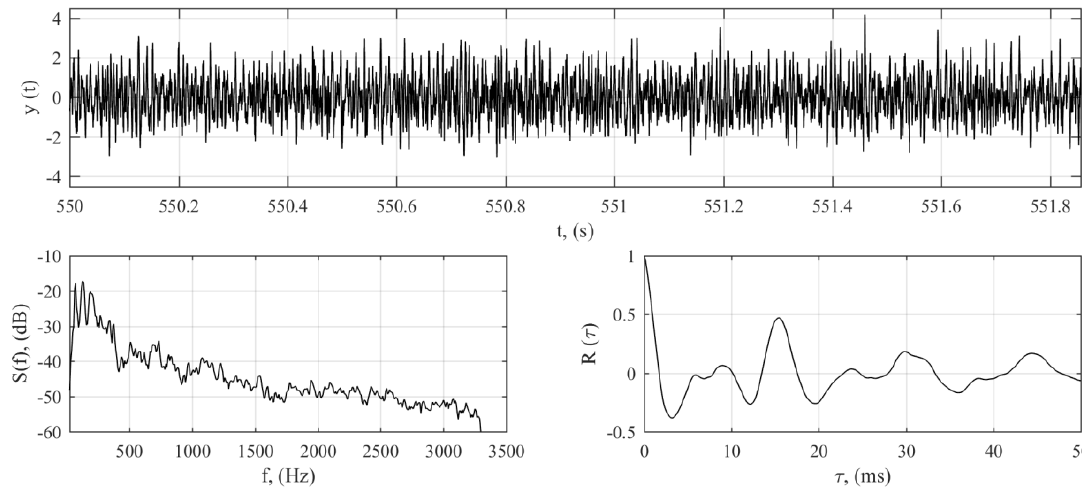
Figure 3. Fragment of characteristics of the same signal (Figure 2, top ). Top—oscillogram, bottom left—the signal fragment mean spectrum, bottom right—the signal initial fragment of the time correlation function.